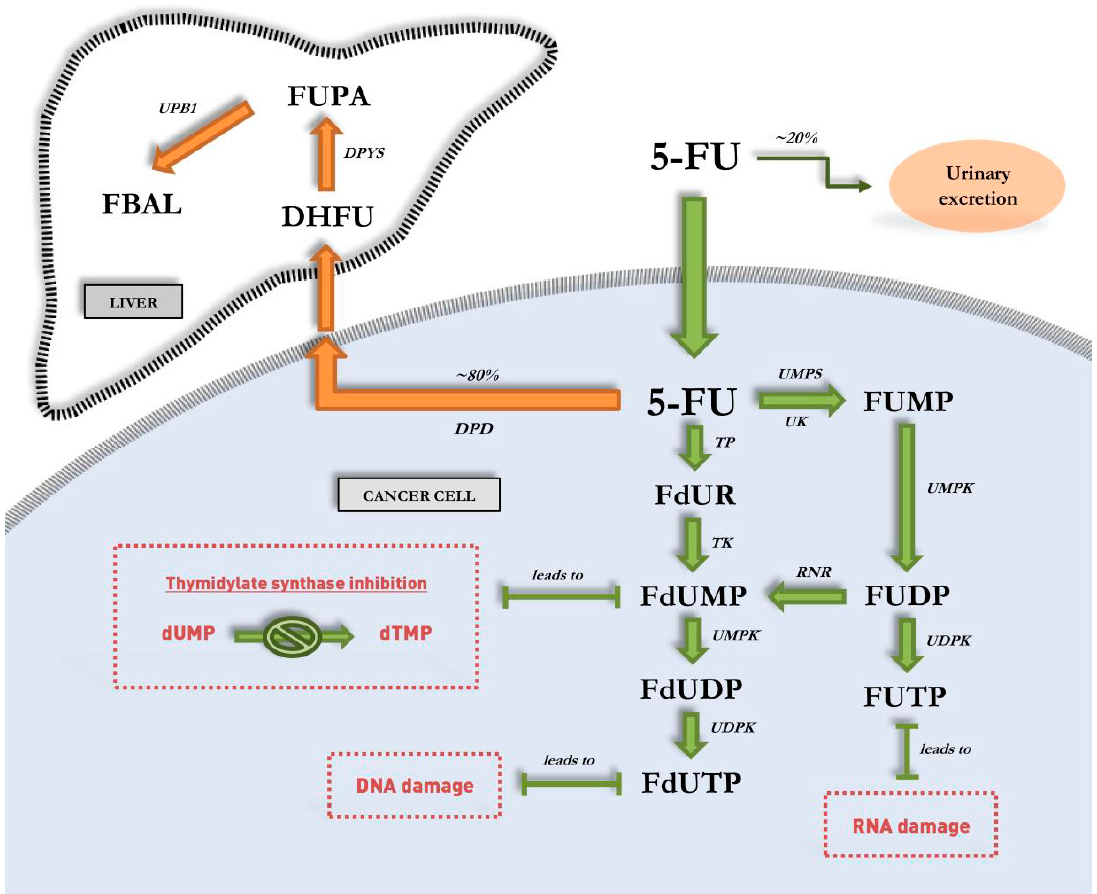
Figure 1. Various key enzymes facilitate the mechanism of action (anabolism) of 5-FU in cancer cells and its elimination (catabolism) via the hepatic system.